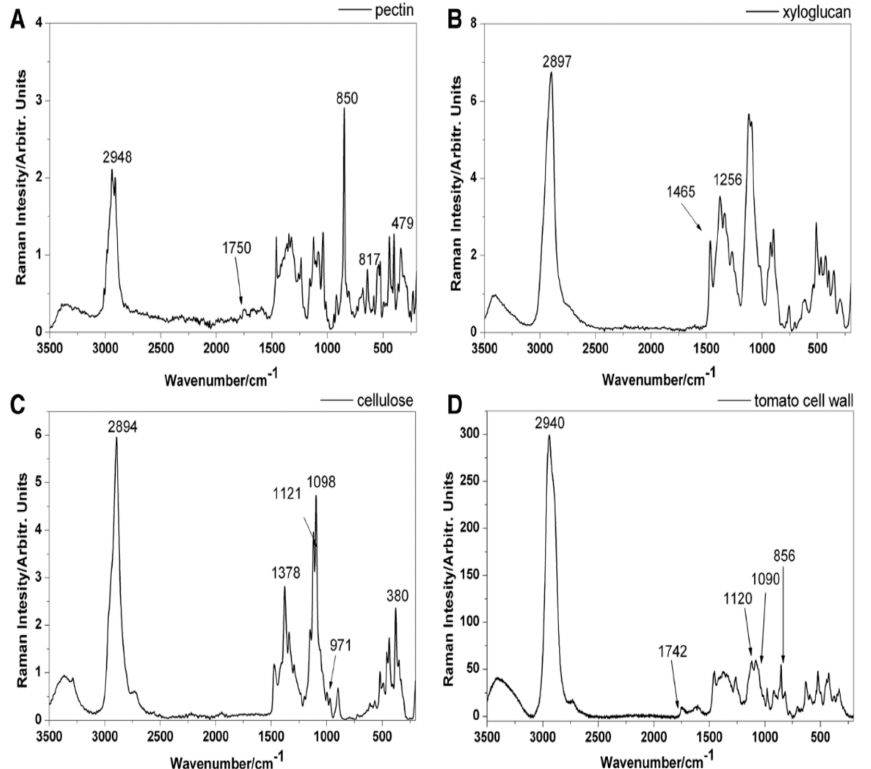
Figure 1. Raman spectra of the pure cell wall components (laser with green light at λ = 532 nm, with a power of 10 mW, the spectra were recorded within the range of 3500–150 cm − 1): pectin ( A ), xyloglucan ( B ), cellulose ( C ), and the Raman spectrum of the tomato cell wall ( D ). Copyright Plant Methods